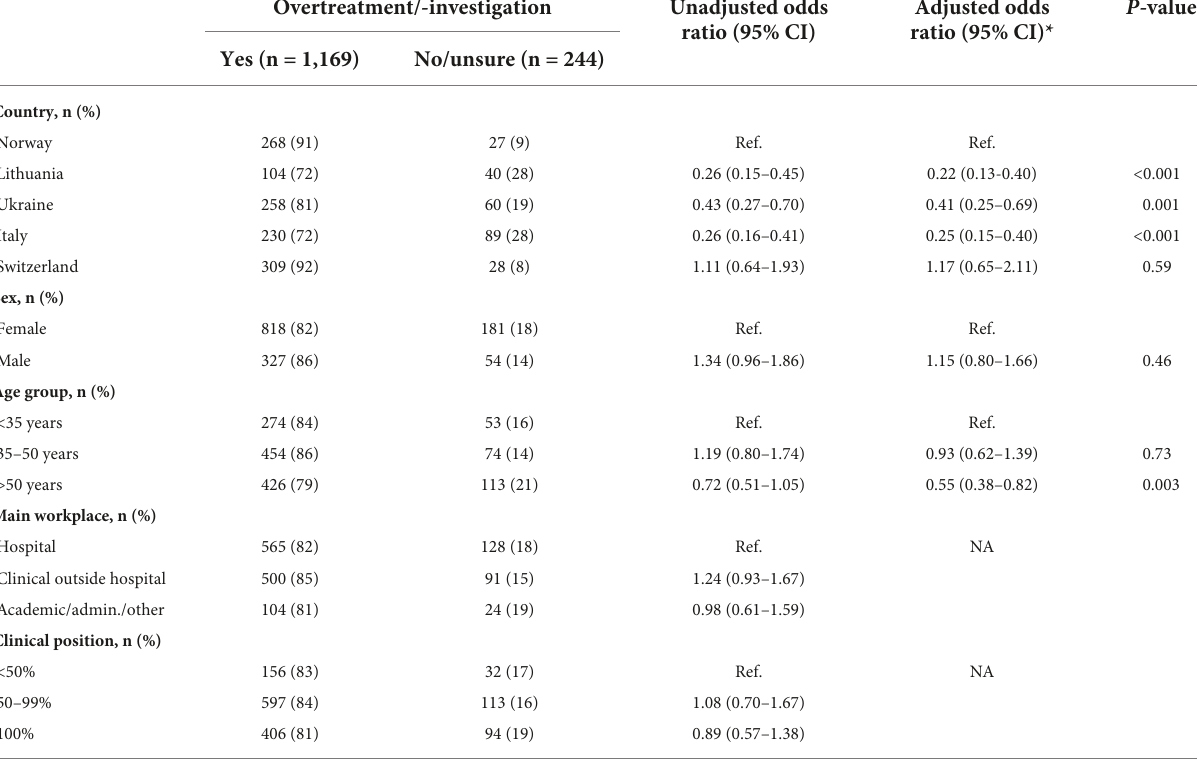
TABLE 2 Predictors for perceiving overtreatment/over-investigation (n = 1376 participants).